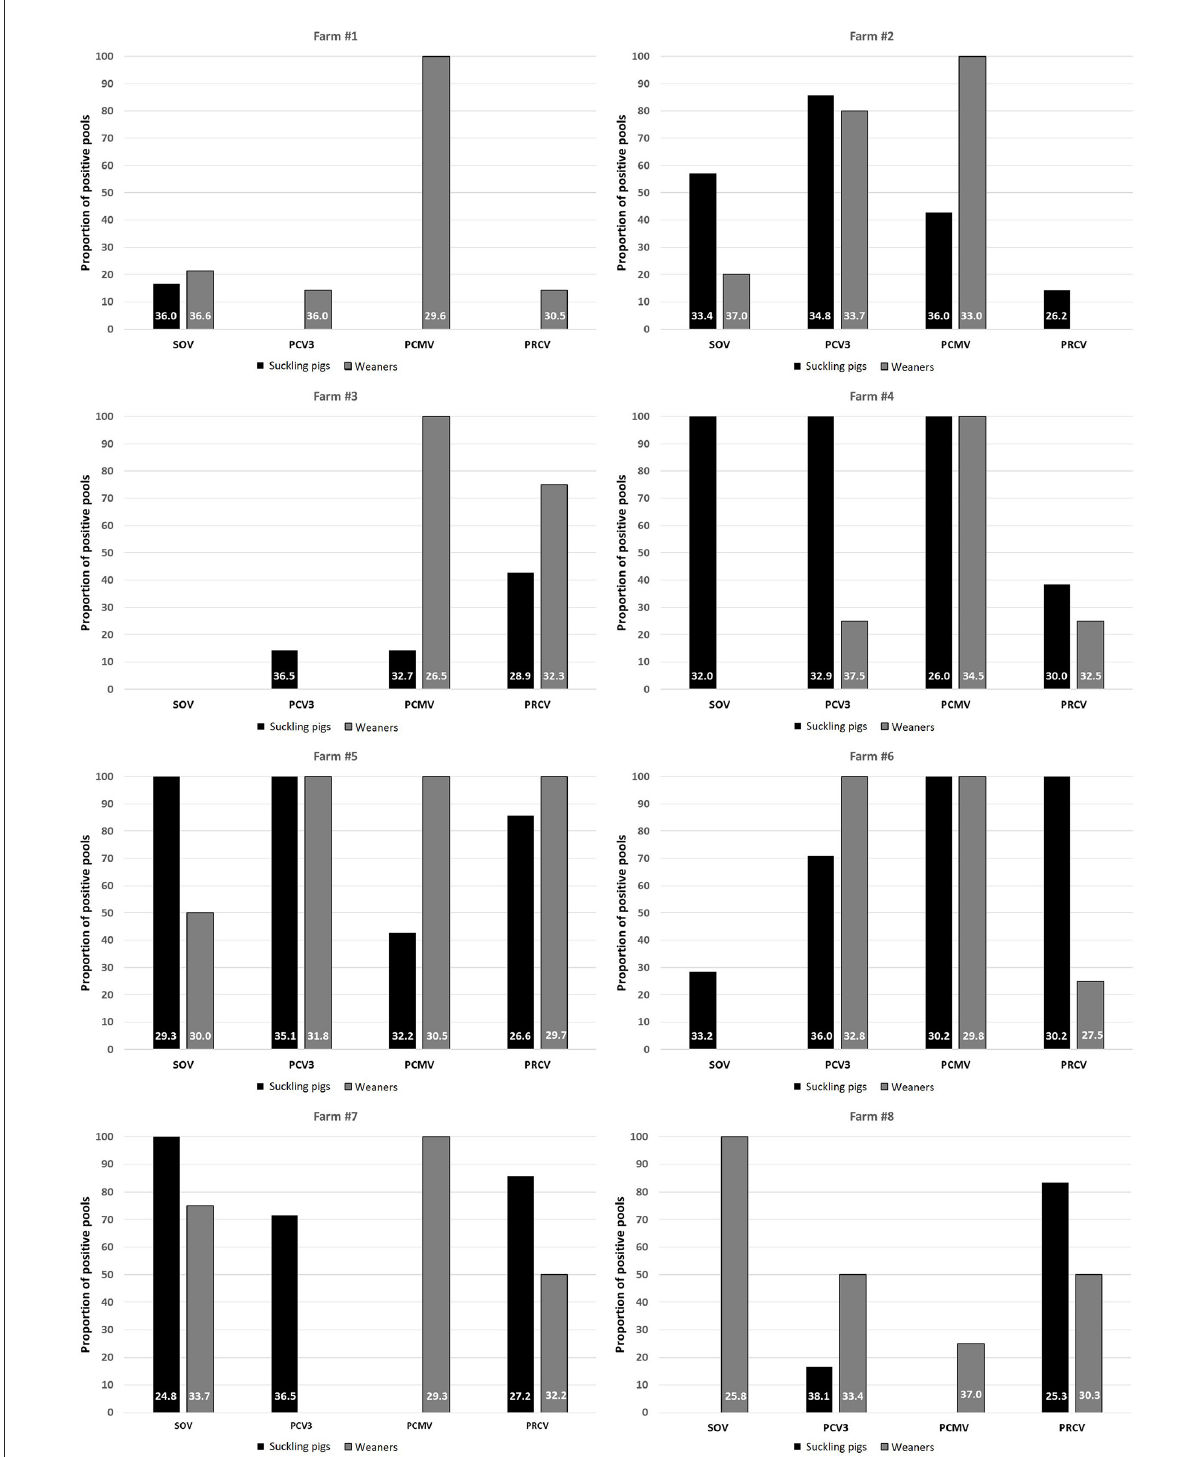
FIGURE3 Proportion of positive pools for SOV, PCV3, PCMV and PRCV in suckling pigs and weaners among 8 monitored farms. The numbers within the bars indicate the average Ct value of the positive samples. PRCV, porcine respiratory coronavirus; SOV, swine orthopneumovirus; PCMV, porcine cytomegalovirus; PCV3, porcine circovirus